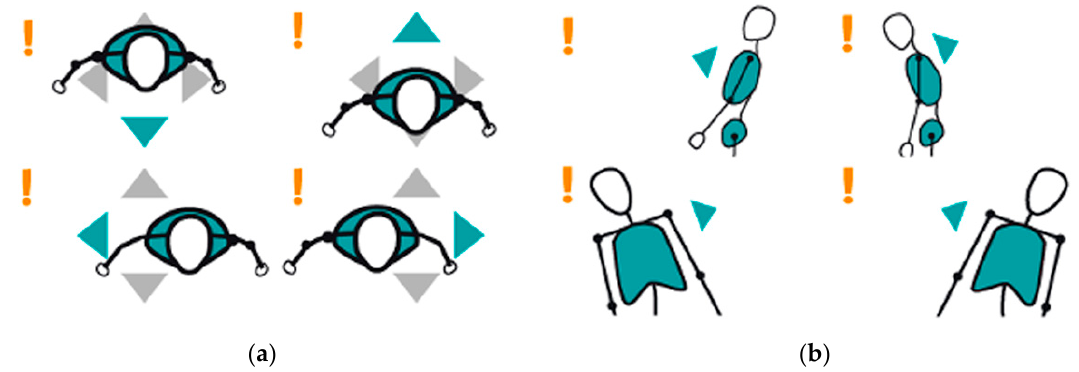
Figure 2. The system indicates the patient how to correct the position in the scene ( a ) and the body posture ( b ).